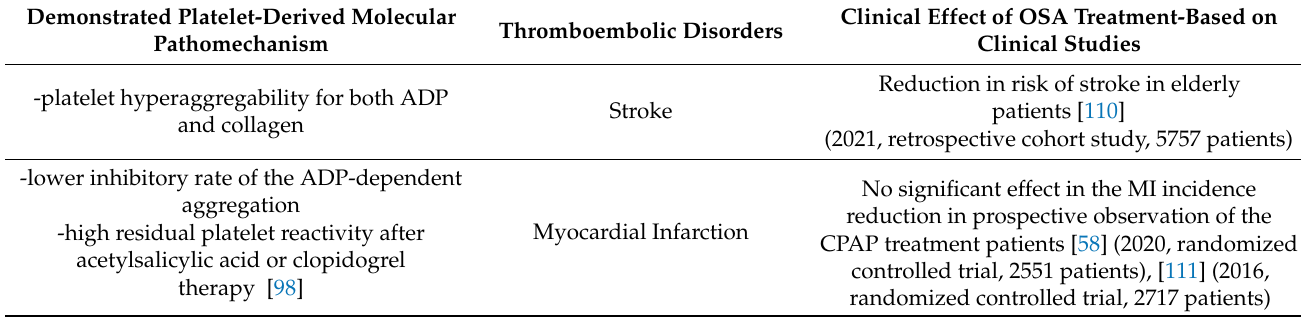
Table 2. Cardiovascular thromboembolic disorders and CPAP